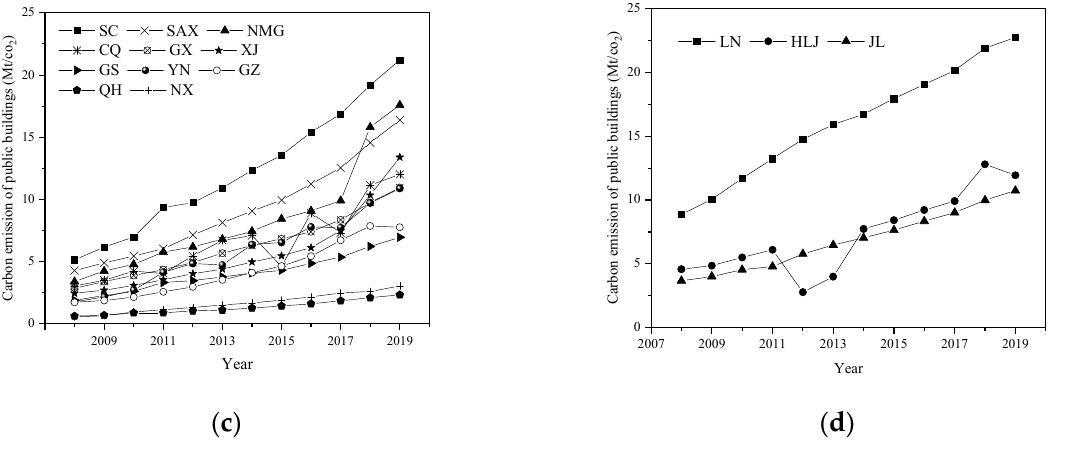
Figure 1. Carbon emission of public buildings in China among provinces during 2008 to 2019: ( a ) Eastern Region; ( b ) Central Region; ( c ) Western Region; ( d ) Northeast Region. GD—Guangdong,